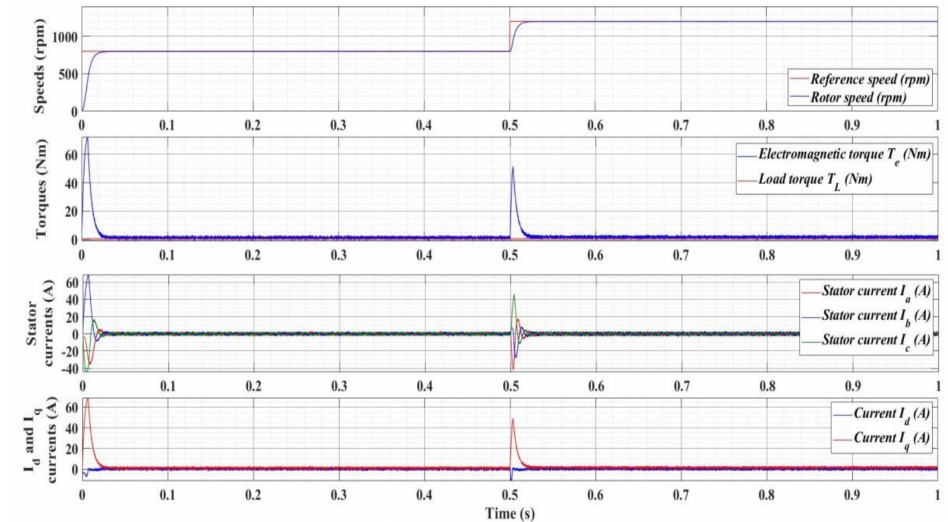
Figure 30. Time evolution for the numerical simulation of the PMSM control system based on the RL-TD3 agent for the correction of u dref and u qref